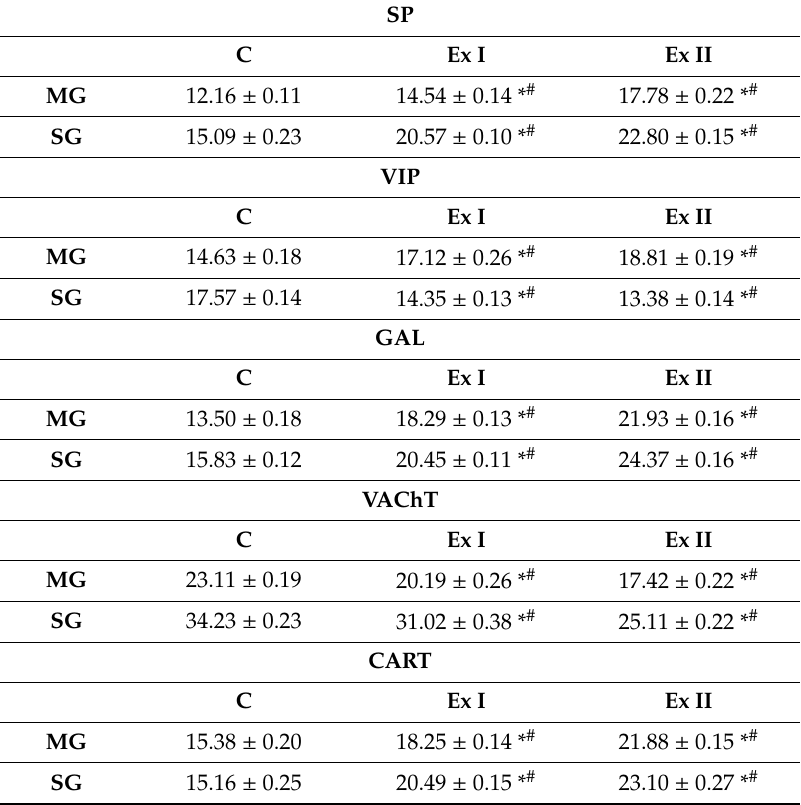
Table 2. The distribution of enteric neurons immunopositive to neuronal active factors in the porcine stomach.